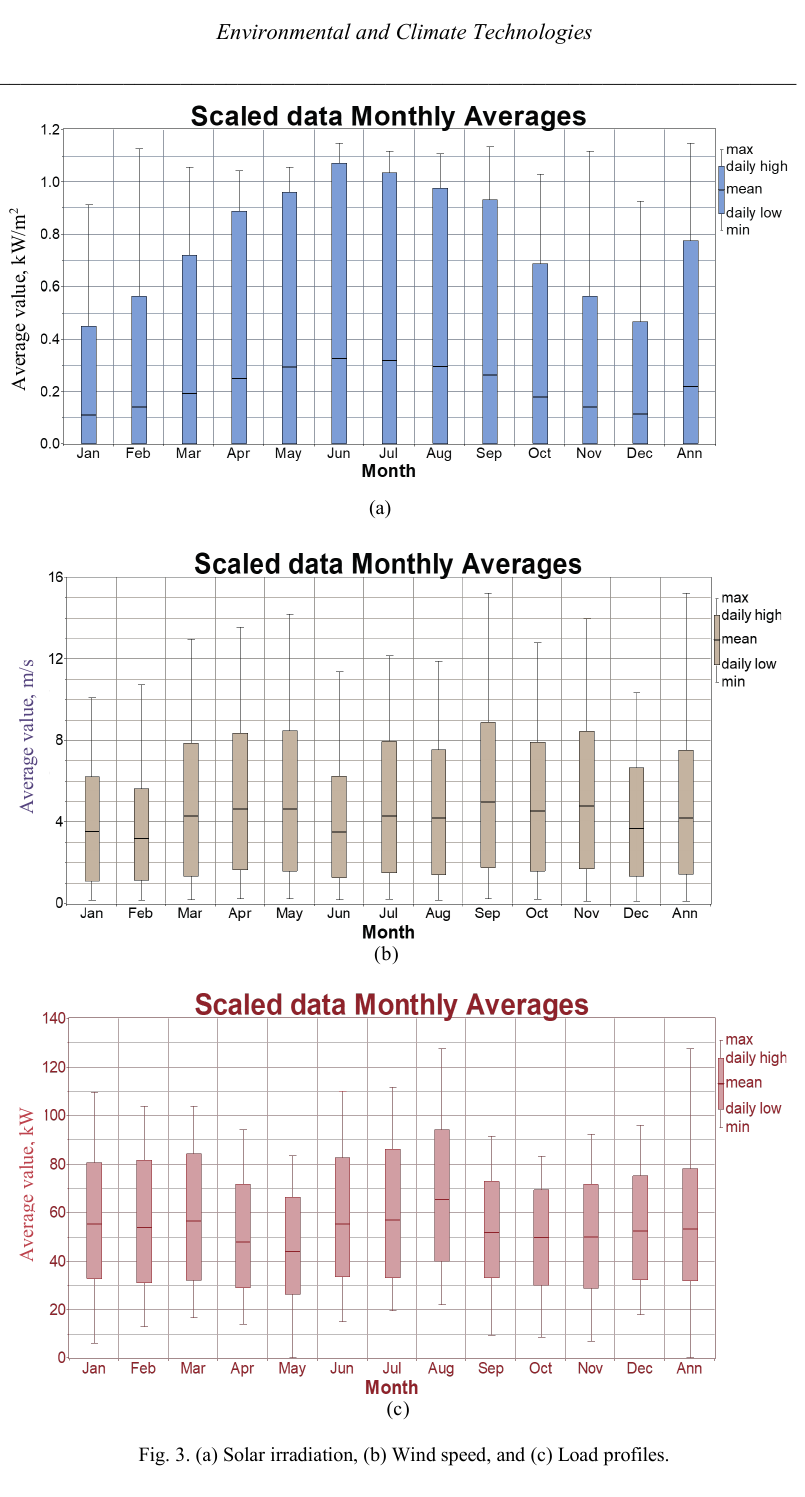
Fig. 3. (a) Solar irradiation, (b) Wind speed, and (c) Load